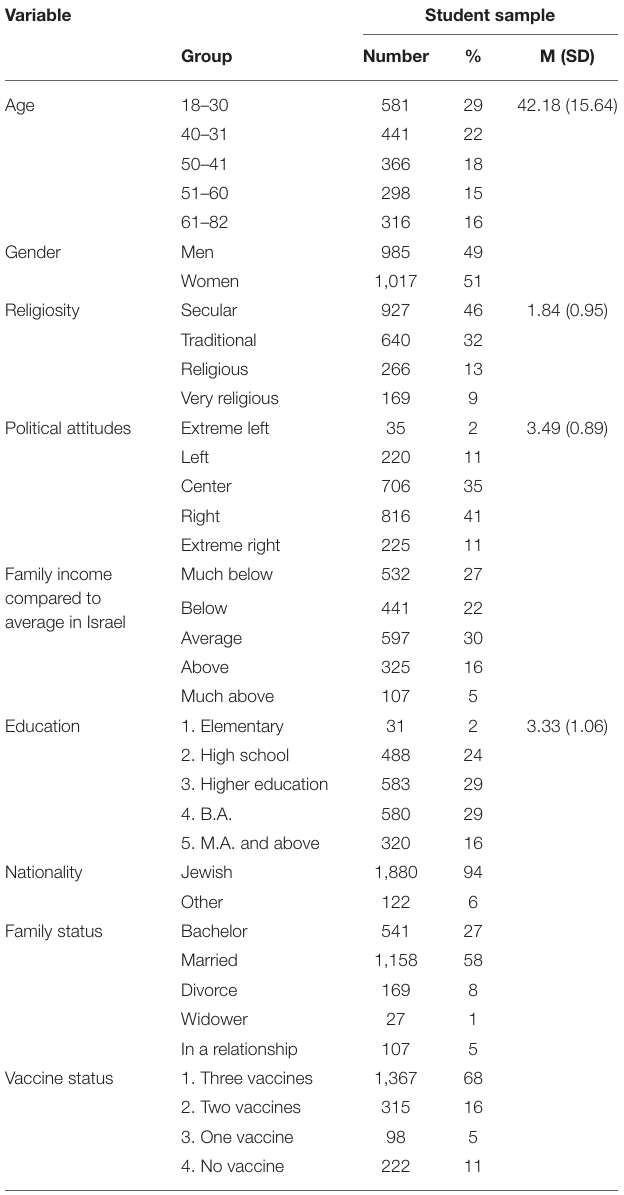
TABLE 1 | Demographic characteristics of the participants. Variable